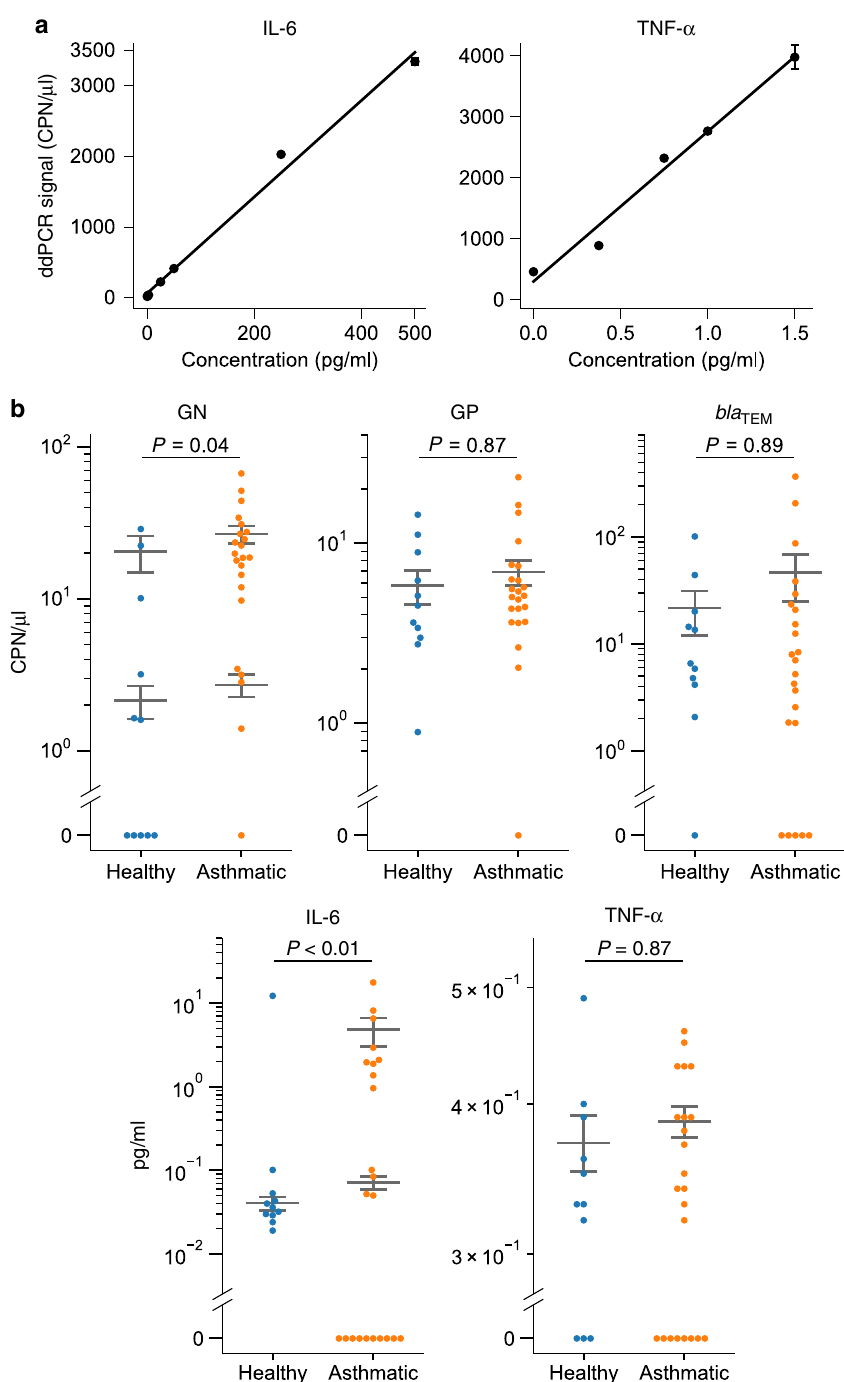
Fig. 3 Molecular markers for asthmatic in fl ammation. a Example digital PLA calibration curves of IL-6 and TNF- α in human BALF samples. Data in ( a ) are presented as mean ± s.e.m., and each concentration has three technical replicates. b The measured concentrations of GN and GP bacteria, bla TEM genes, IL- 6, and TNF- α proteins in the healthy subjects ( n = 11) and patients with asthma ( n = 23). The gray lines in ( b ) indicate the mean ± s.e.m. of the populations (or subpopulations) of detectable samples within each group. ( b ) Two-sided two-part statistical test 62,63 with Benjamini – Hochberg recovery. Group B patients ( n = 13) required more than 48 h for We quanti fi ed the amount of GN and GP bacteria, bla TEM level, IL-6, and TNF- α in plasma from patients with septic shock shock resolution, and were designated as late recovery. Group B (Fig. 4b; Supplementary Fig. 9), and observed clear correlations patients had a third blood sample drawn at an additional third time between patient outcomes and the temporal changes of GN, GP, point, t 3 = 24 h after resolution of shock. Group C patients ( n = 12) never recovered from septic shock and died in the ICU. Plasma was and IL-6. First, we con fi rmed that plasma samples from healthy collected and frozen at − 80 °C. More information on the sample individuals did not contain any detectable bacterial levels collection is available in the “ Methods ” . (Supplementary Fig. 8a, b). On the other hand, almost all septic